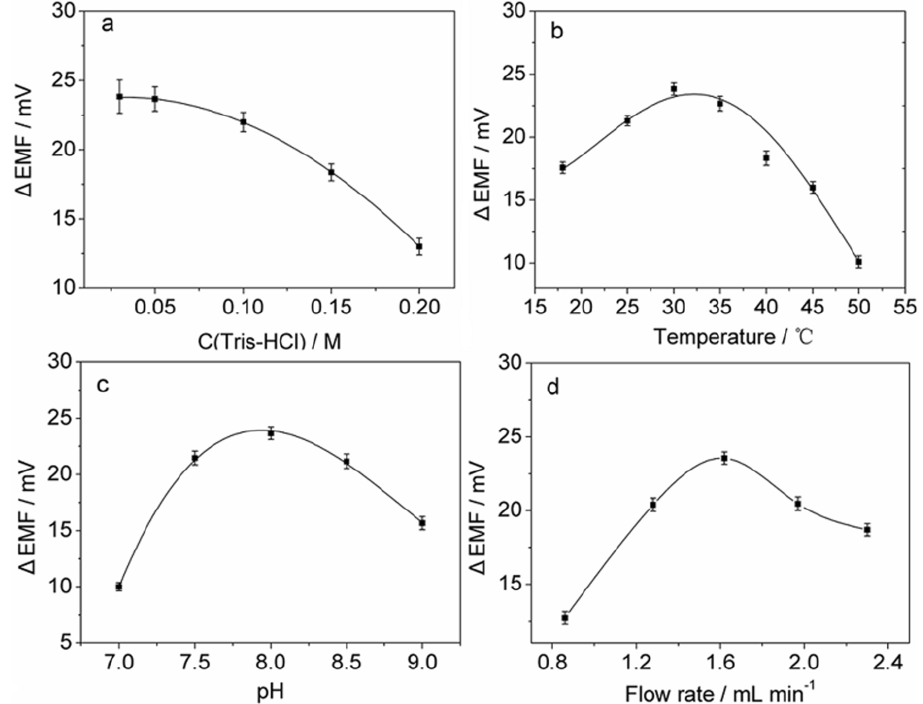
Figure 2. Effects of ( a ) buffer concentration, ( b ) temperature, ( c ) sample pH, and ( d )